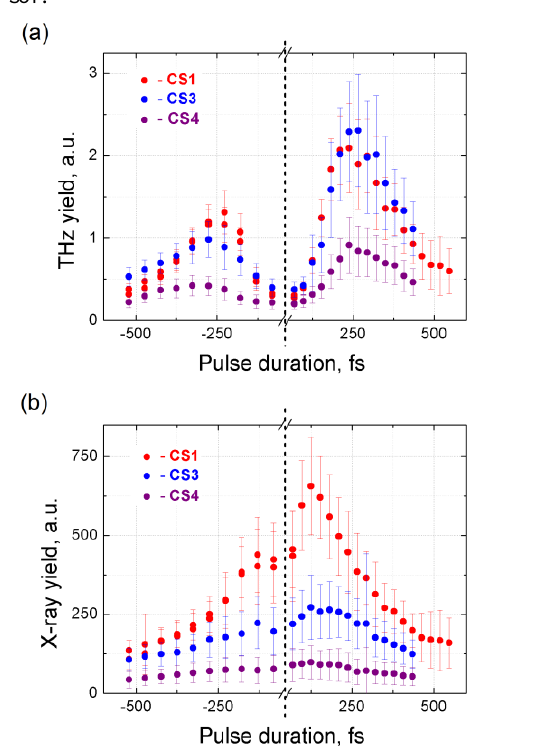
Fig. 3. X-Ray (a) and THz (b) yields from an Ar gas- clusters jet as a function of the temporal duration of the excitation laser pulses recorded at the cross-sections of CS1 (red dots), CS3 (blue dots), and CS4 (purple dots). The ver- tical dotted line in the center represents the pulse duration for a Fourier limited